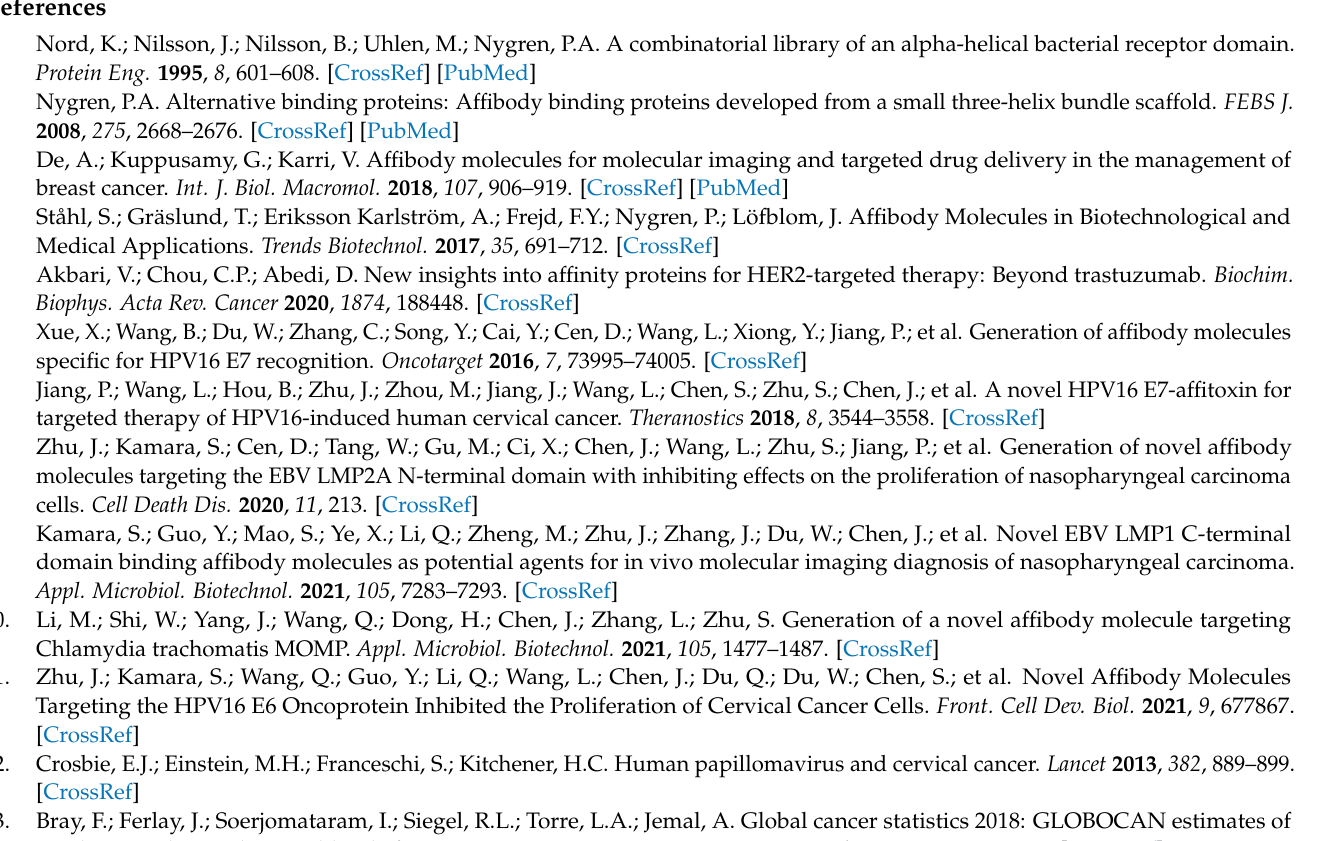
Figure S2: FITC-labelled Z HPV16E7 384 could bind specifically to the HPV16 positive cells; Figure S3: The internalization of Z HPV16E7 384 was independent of IgG; Figure S4: HPV16E7 localized on the cell membrane of the SiHa cells; Figure S5: The CDE inhibitor CPZ had no effect on the internal- ization of Z HPV16E7 384; Figure S6: The micropinocytosis inhibitor Wortmannin had no effect on the internalization of Z HPV16E7